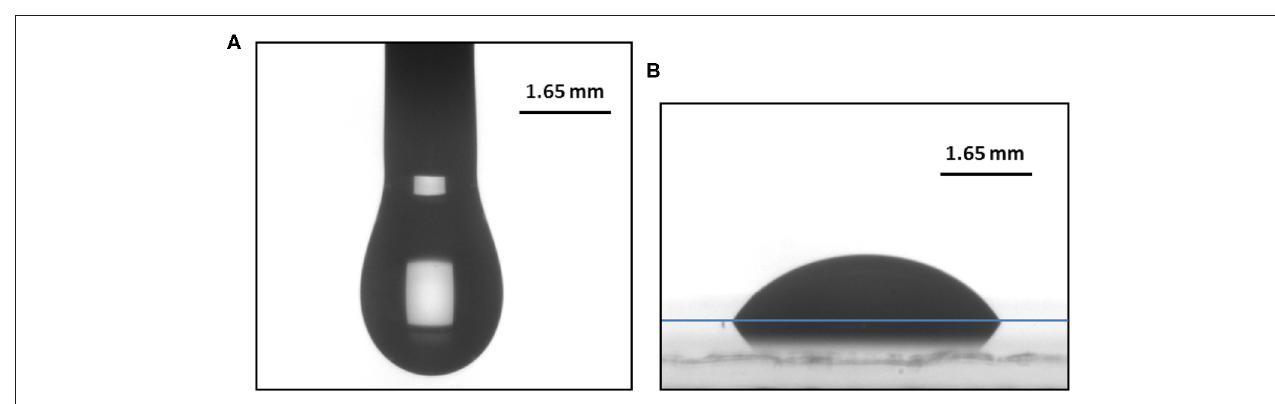
FIGURE 1 | (A) Pendant drop of PEG10000 at T = 95 ◦ C . (B) Sessile drop of PEG10000 at 95 ◦ C on a microscope glass slide.